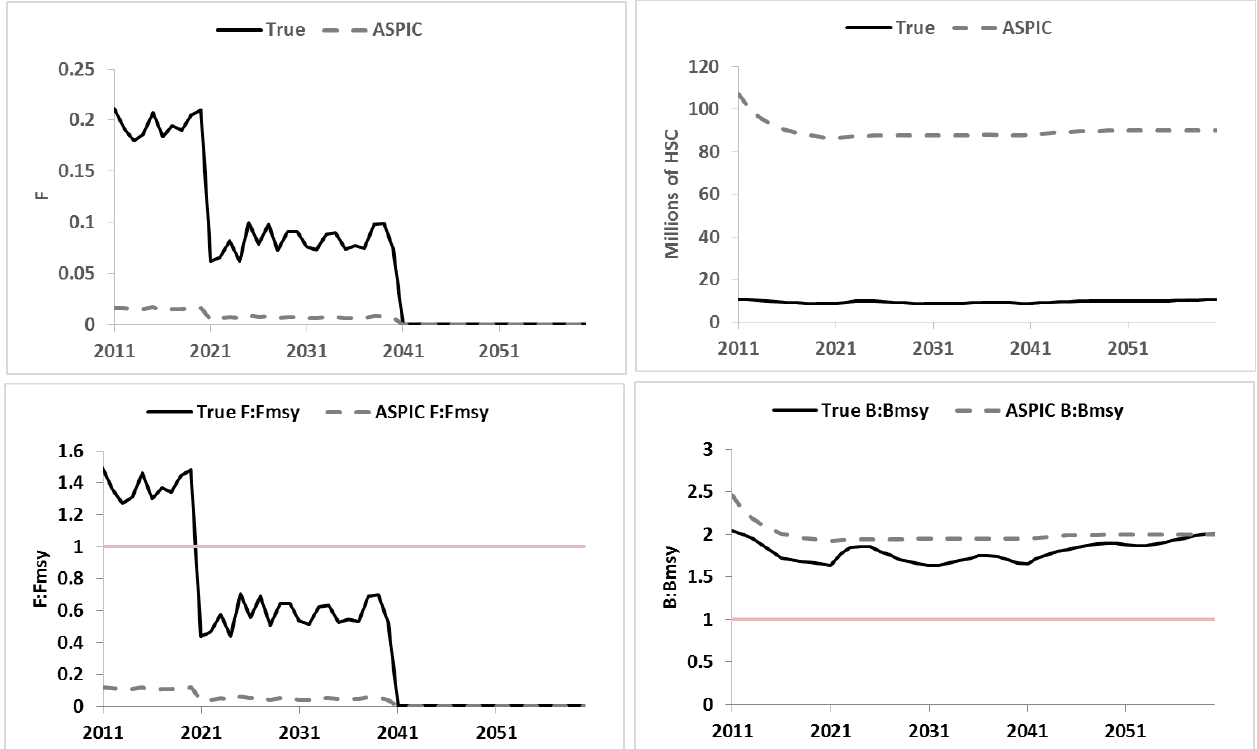
Figure 94. Comparison between simulated “true” data from the operating model and surplus production (ASPIC) results for simulation 4.